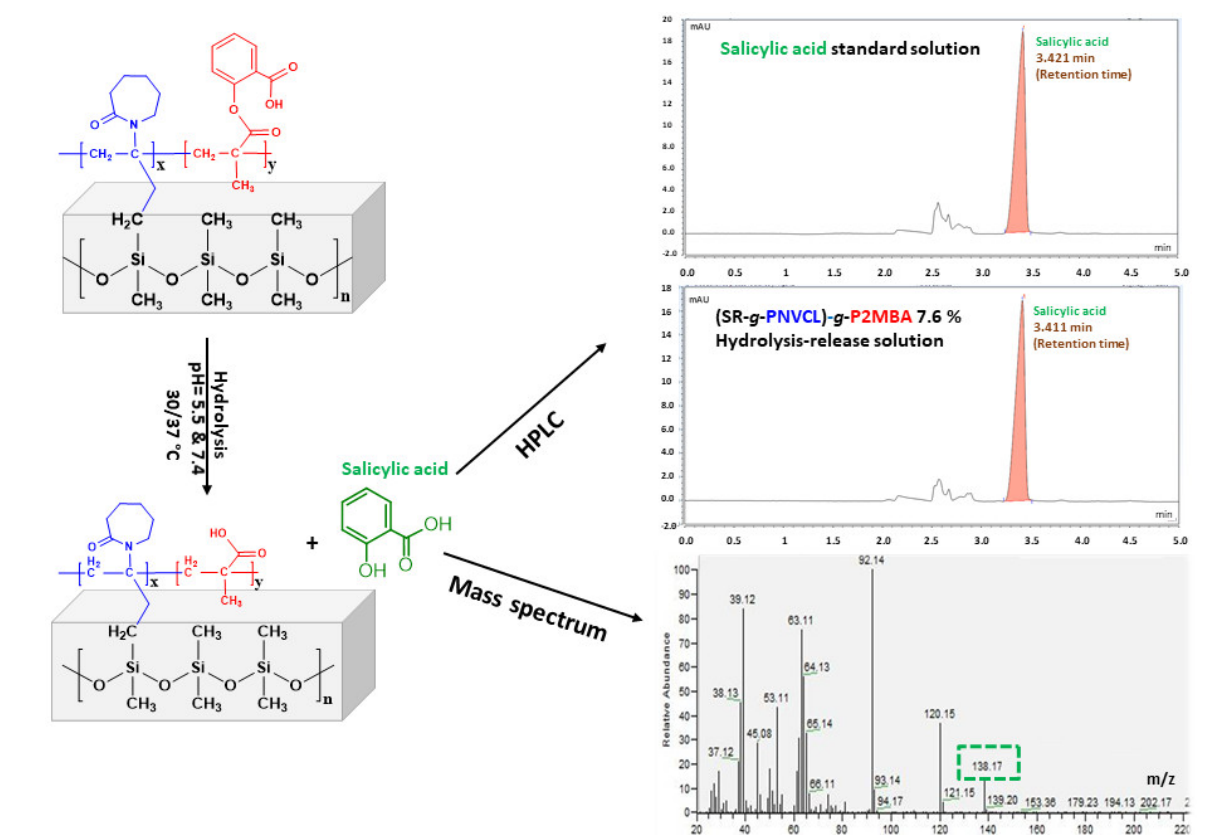
Figure 8. Hydrolysis–release of salicylic acid from (SR- g -PNVCL)- g -P2MBA films, HPLC quantification, and molecular ion detection.